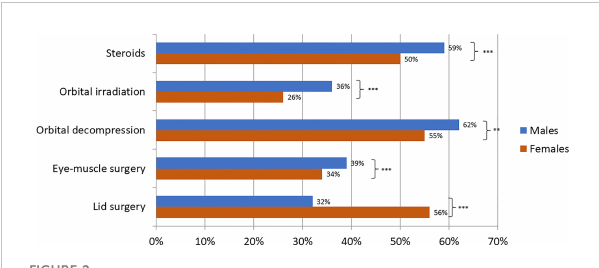
FIGURE 2 Treatments for GO patients strati fi ed by sex as proportions. (Fisher ’ s exact test, **<0.01 ***< 0.001)